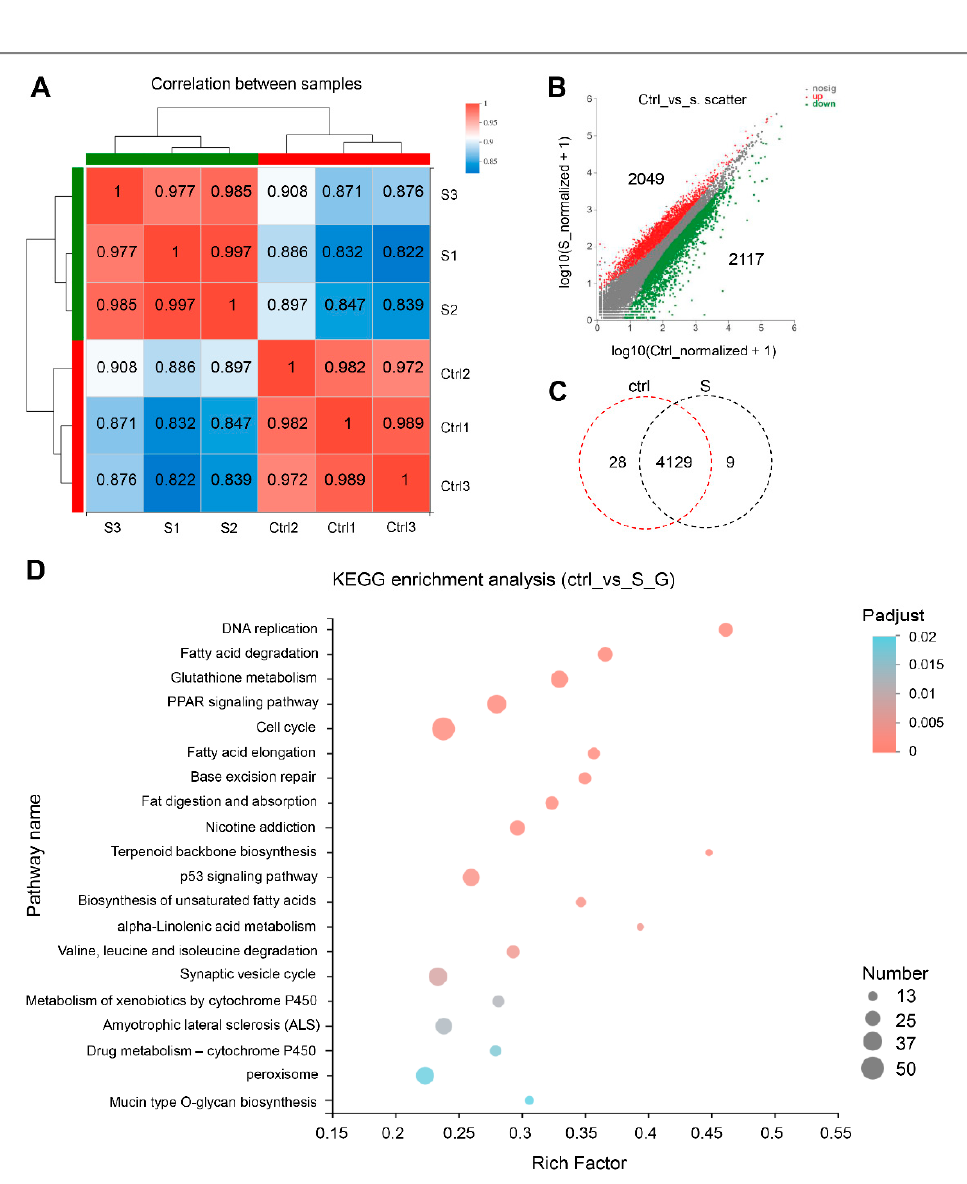
Figure 2. Gene expression and functional enrichment analysis of RNA-seq data. ( A ) Correlation analysis of intra-group and inter-group samples, respectively. ( B ) Scatter plot of differentially expressed genes in the control and starvation larvae. The red dots indicate up-regulated genes, and green dots indicate down-regulated genes. Ctrl represents the control group, that is, normal feeding larvae; S represents the starvation group. ( C ) Venn diagram analysis of differentially expressed genes in the control and starved larvae. ( D ) Scatter plot for KEGG enrichment analysis between control and starved larvae. The size and color of the circles represent the number of DEGs and the p -adjust value, respectively.